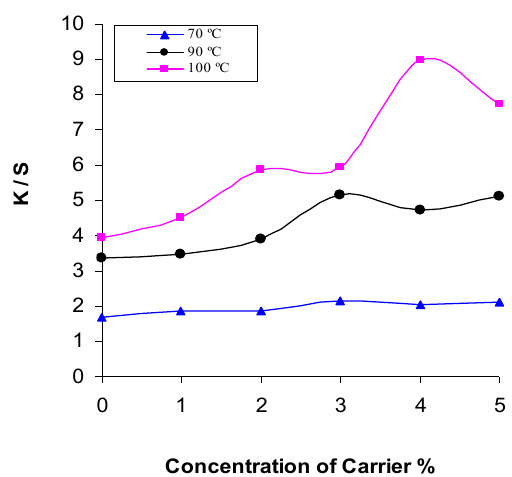
Figure 2. Effect of the concentration of carrier on the dyeing for disperse dye 3b at different dyeing temperatures.